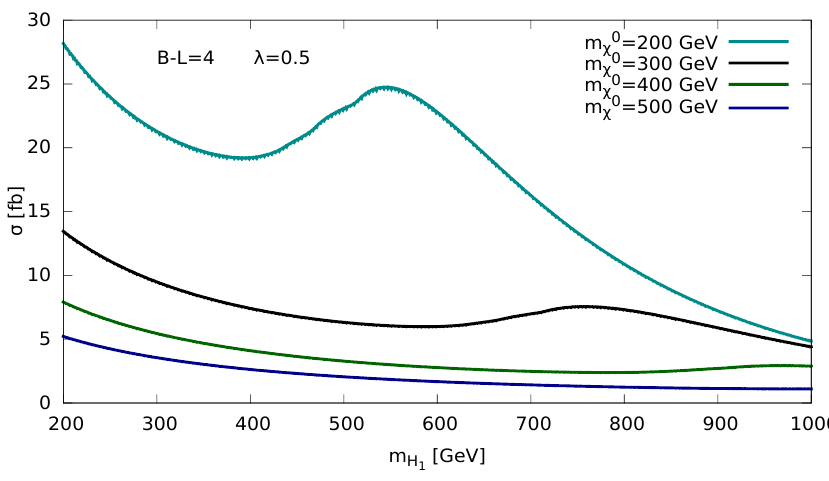
Figure 7 . The production cross-section of singlet scalar ( H 1 ) as a function of its mass for various choices of DM mass ( m ). The curves are shown for B (cid:0) L = 4 case with (cid:21) = 0 : 5. (cid:31) 0 p photon luminosity at s = M as H 1